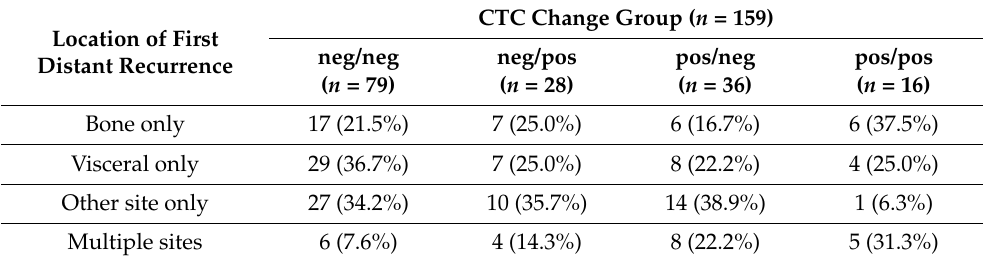
Table 3. Association between site of first metastatic disease recurrence and CTC change group. Location of